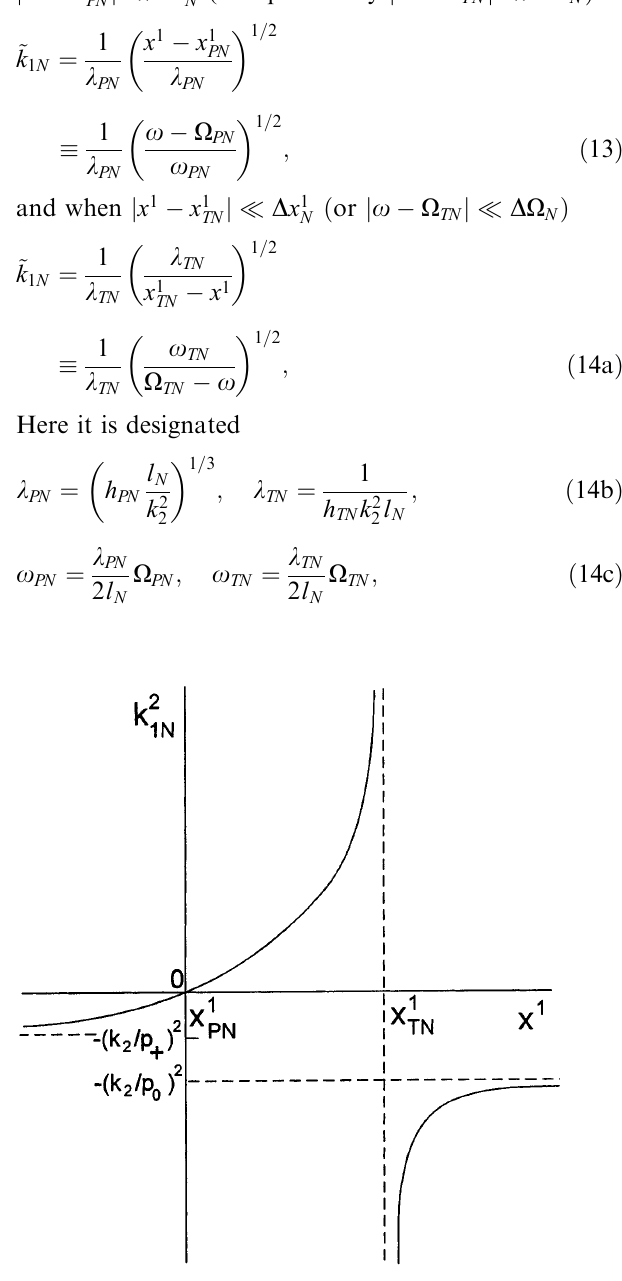
(cid:133) x 1 ; (cid:120) (cid:134) of a quasi-classical N